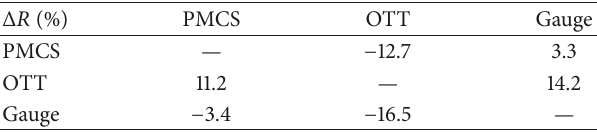
Table 5: Variances of accumulated rainfall obtained from the PMCS, OTT, and